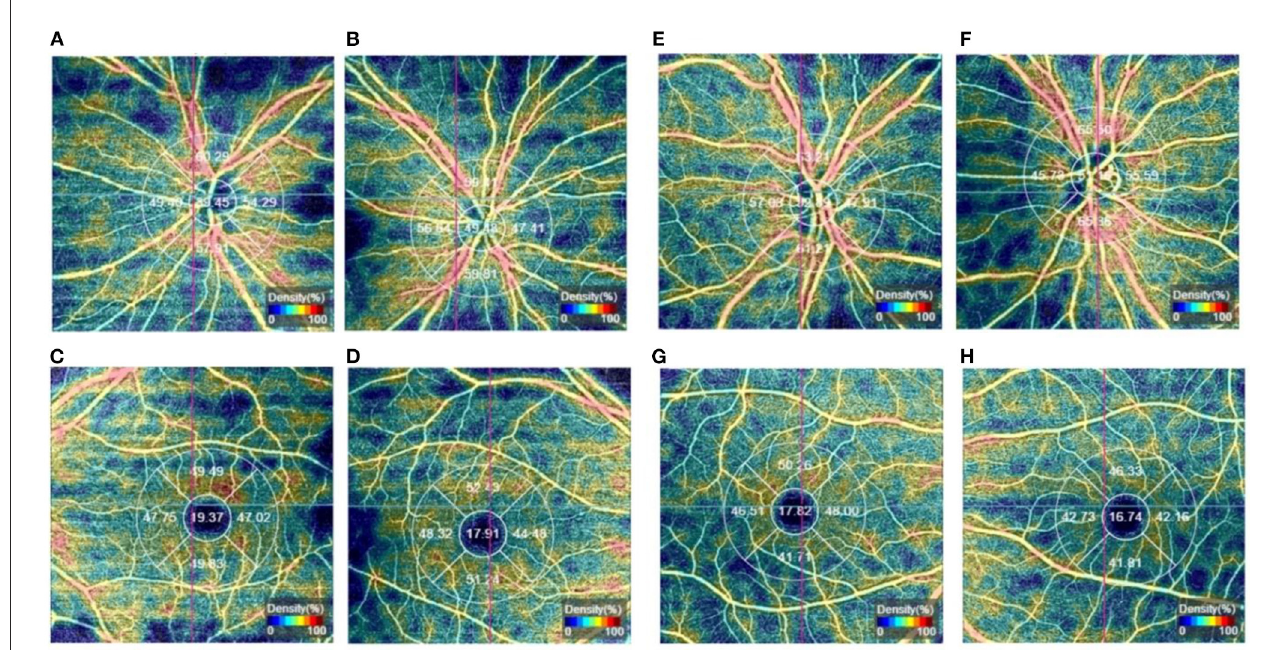
FIGURE5 (A–D) One patient in the non-improvement group, (A, C) are the affected eyes, the microvessel density in the center of the optic disc and superior macula was significantly lower than that of the healthy eye; (B, D) are the healthy eyes; (E–H) One patient in the improvement group, (E, G) are the affected eyes, (F, H) are the healthy